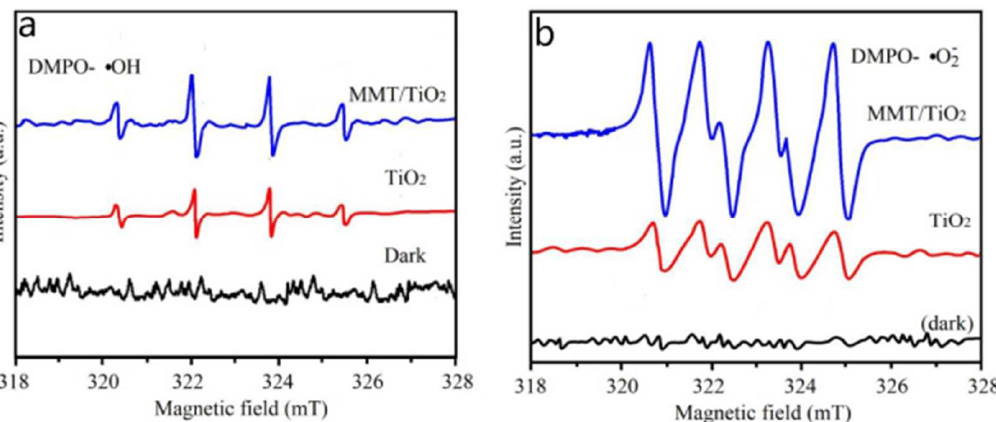
Figure 9. Electron paramagnetic resonance signals of ( a ) 5,5-dimethyl-pyrroline N-oxide (DMPO)- · OH and ( b ) DMPO- · O 2− obtained for catalysts irradiated with visible light.